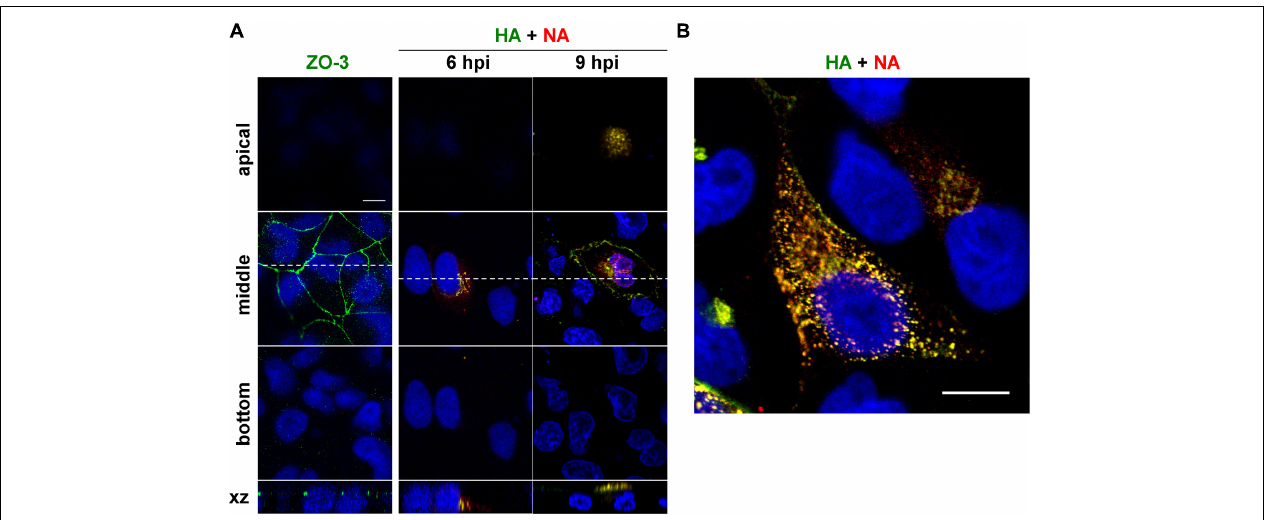
FIGURE 1 | Relocation of HA and NA in polarized MDCK cells. Polarized MDCK cells were infected with an influenza A virus derivative containing H141Y and E142Q substitutions in HA (referred as to a wild-type virus) (Ohkura et al., 2014). (A) Polarization of MDCK cells was confirmed by staining with anti-ZO-3 mAb (green). At 6 and 9 hpi, cells were stained with anti-HA mAb (green), anti-NA Ab (red) and cell nuclei (blue) were stained with DAPI. Confocal images in the xy planes at the apical, middle, and bottom positions and reconstituted images in the xz planes were shown. Dashed lines in xy images indicate the positions of xz images. All images were taken at the same magnification. (B) Enlargement of the confocal xy images. Scale bar, 10 µ